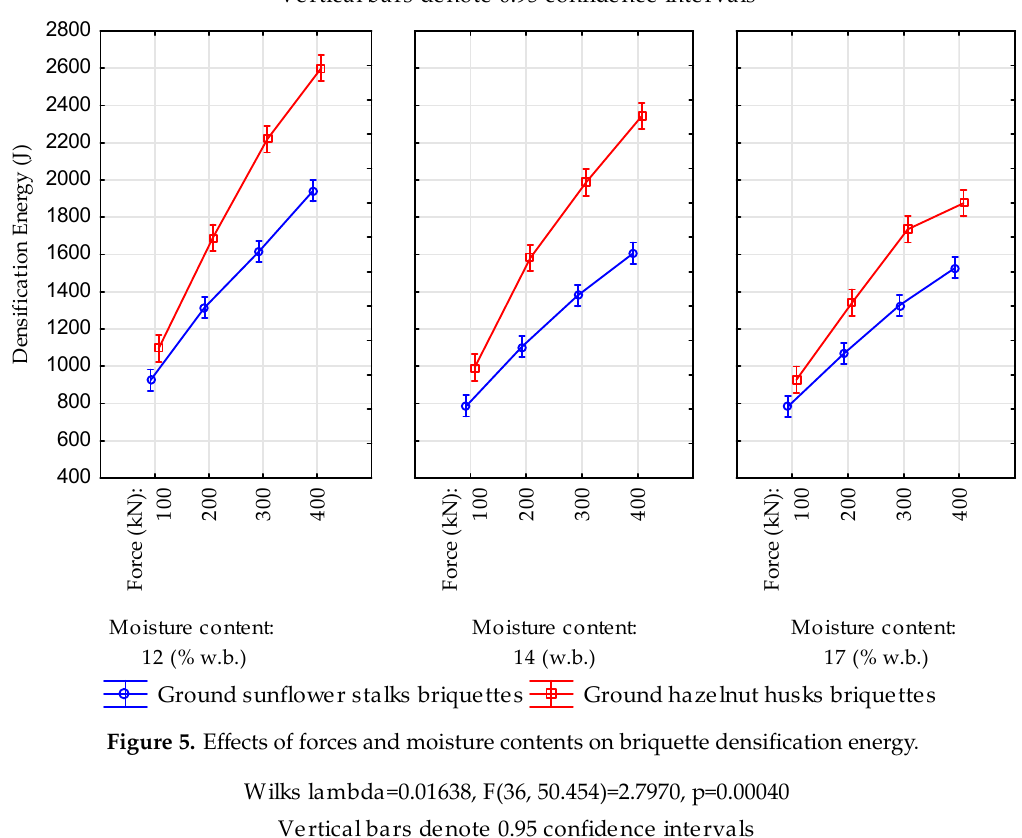
Figure 4. Effects of forces and particle sizes on briquette densification energy. Wilks lambda=0.04136, F(12, 22)=7.1818, p=0.00004 Vertical bars denote 0.95 confidence intervals